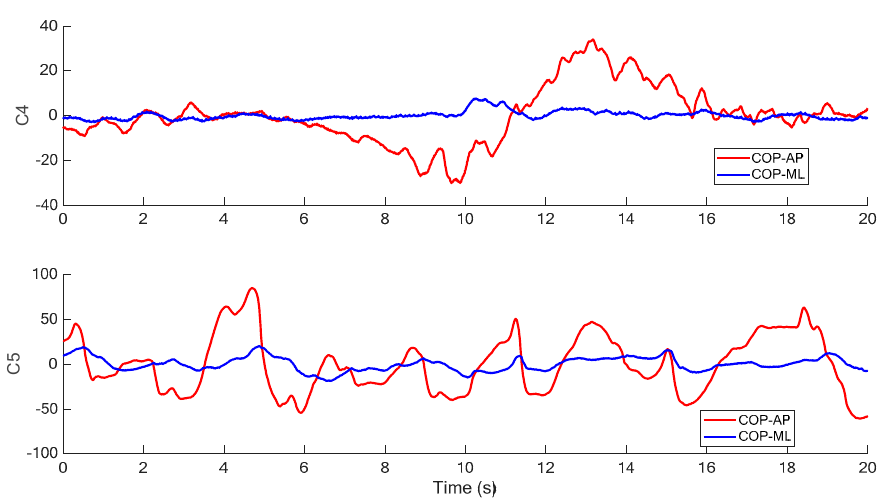
Figure 7. COP measurements in ML and AP direction under Conditions 4–5.